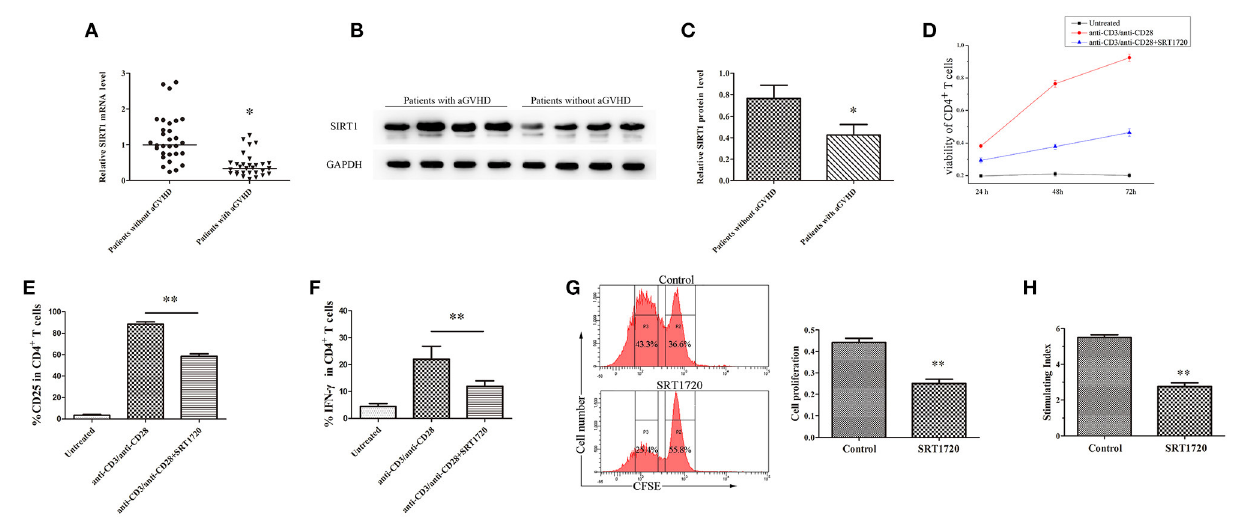
FIGURE 1 | SIRT1 deficiency enhanced CD4 + T cell activation in patients with aGVHD. (A) Relative mRNA level of SIRT1 in CD4 + T cells from patients with aGVHD ( n = 30) and patients without aGVHD ( n = 30) normalized to GAPDH. (B,C) (B) Representative Western blotting result for SIRT1 protein expression in CD4 + T cells from patients with aGVHD ( n = 10) and patients without aGVHD ( n = 10). (C) Quantitative analysis of the band intensities for SIRT1 protein level normalized by GAPDH. (D) Determination of viability of CD4 + T cells unstimulated or stimulated, treated or not with SRT1720. (E,F) Percentage of CD25 + and IFN- γ + cells among CD4 + T cells unstimulated or stimulated, treated or not with the SRT1720. (G) The CFSE labeled CD4 + T cells were activated with anti-CD3/anti-CD28 antibodies and IL-2, and treated with/without SRT1720. The proliferation of CD4 + T cells were detected by flow cytometry. (H) PBMCs and RPMI 1788 cells were mixed culture with/without SRT1720. The 3H-TdR incorporation was used to detect PBMCs proliferation. Data are presented as the mean ± standard deviation (SD) of the same experiments performed in three times. * p < 0.05, ** p <